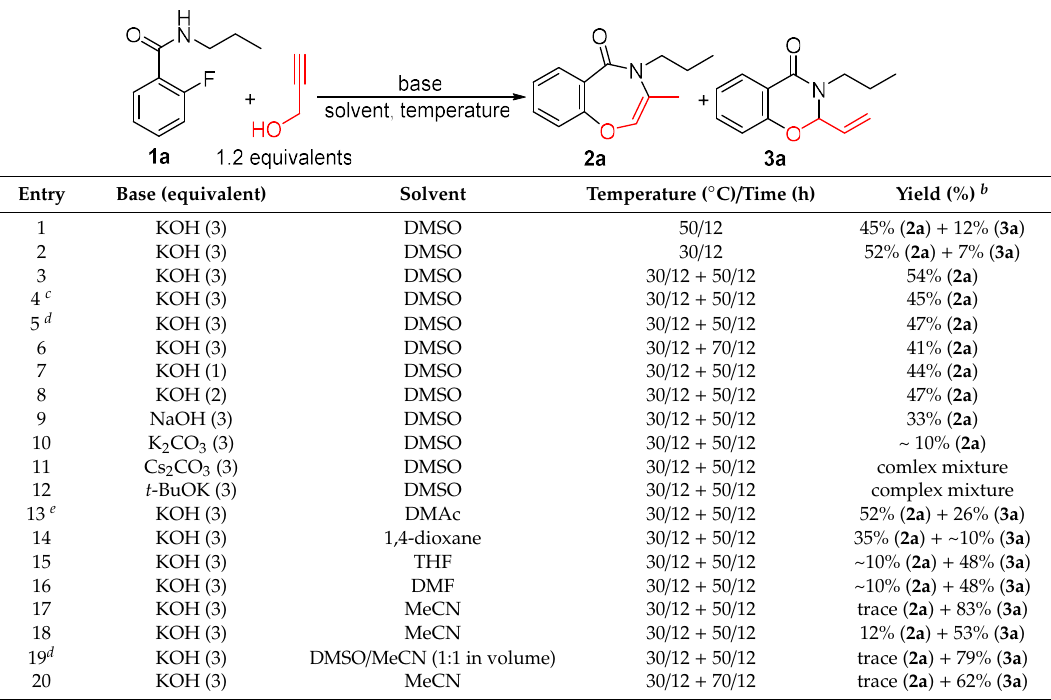
Table 1. E ff ects of reaction conditions on the chemodivergent formation of 1,4-benzoxazepin-5(4 H )-ones and 1,3-benzoxazin-4(4 H )-ones a